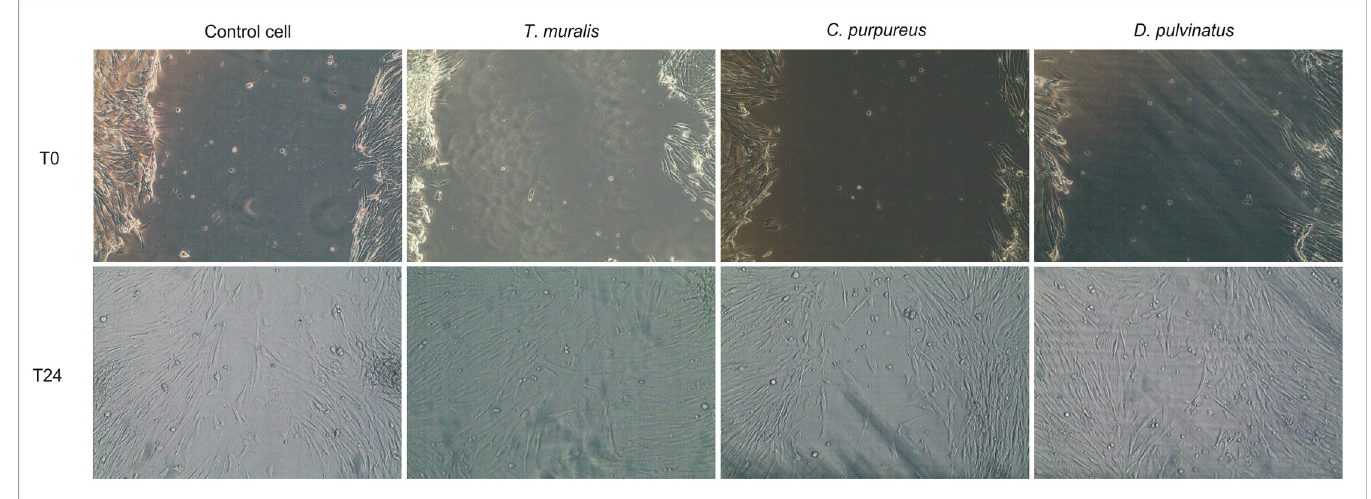
Fig 8. The effect of moss extracts on human foreskin fibroblasts (HFF-1) migration tested in vitro by scratch assay. Representative images of the scars taken just after scratching (T0) and 24 h later (T24).